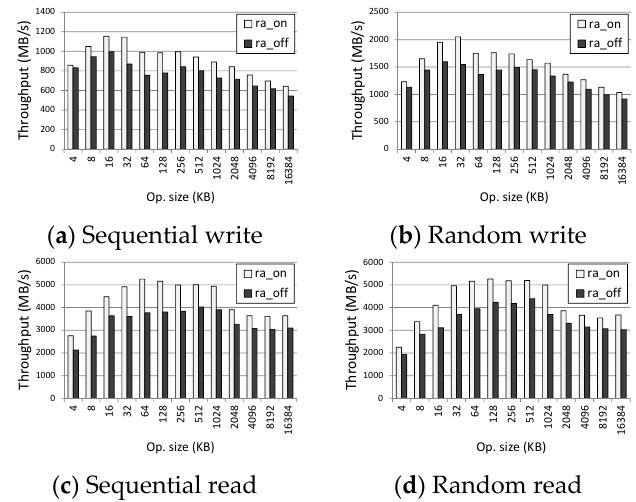
Figure 8. HDD performance when the prefetching option is turned on/off.